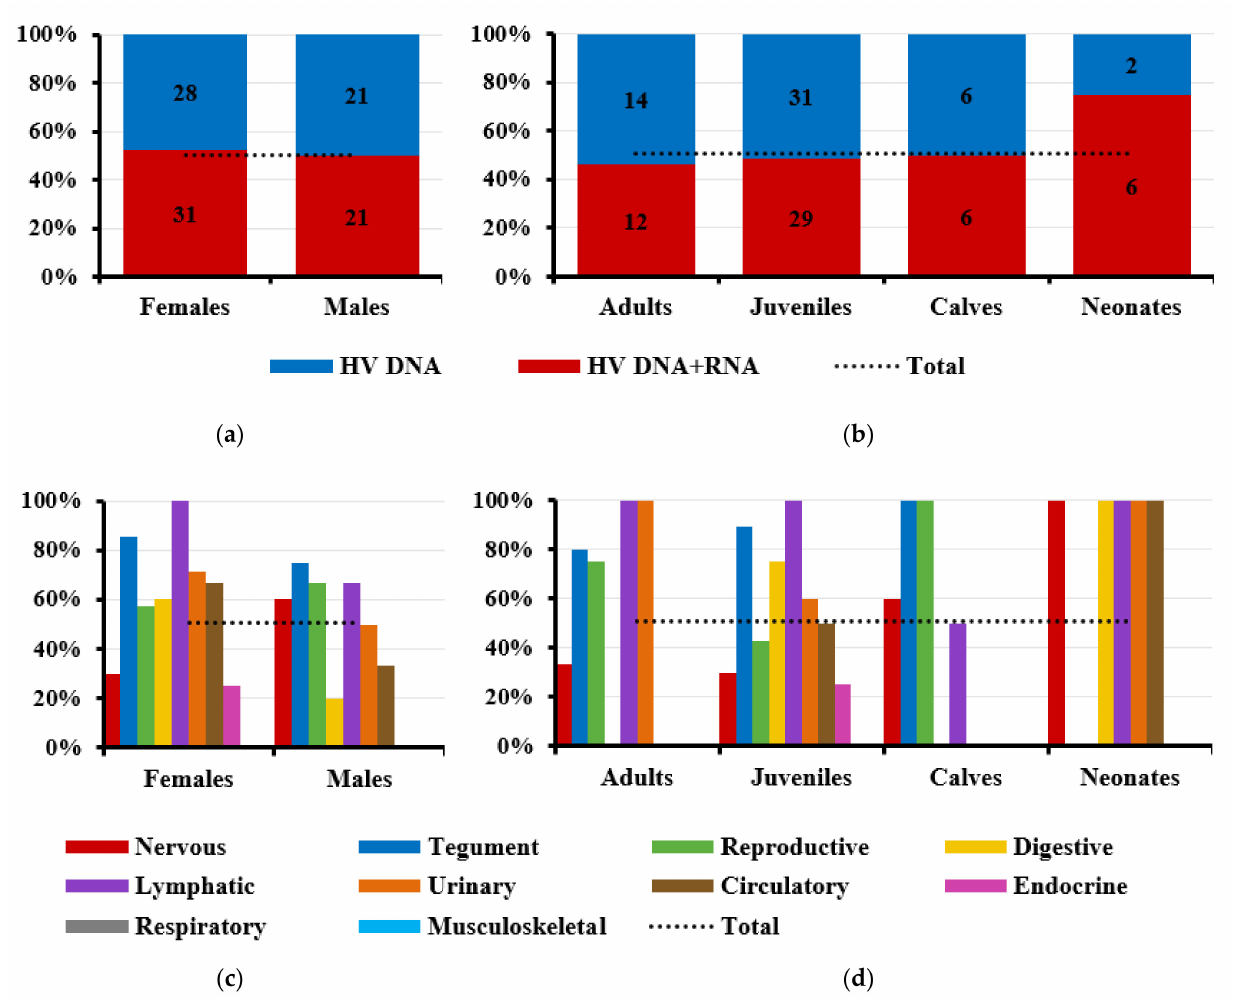
Figure 5. HV active replication in the tissues stratified by gender and age of the animal. Detection of active HV replication, defined as the presence of HV RNA, in tissues positive for HV DNA and GAPDH RNA. The dotted line indicates the proportion of tissue samples with active replication across ages and sexes (54/107, 50.47%). ( a , b ) Comparison of tissue samples that tested positive for only HV DNA or for both HV DNA and RNA (among all samples that were positive for GADPH RNA), stratified by sex ( a ) and age ( b ). Number of positive tissues is shown for each category. ( c , d ) Comparison of organ systems positive for only HV DNA or for both HV DNA and RNA (among all samples positive for GADPH RNA), stratified by sex ( c ) and age ( d